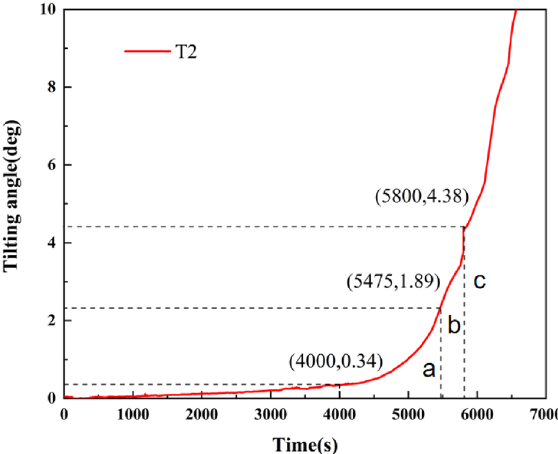
Figure 9. Curve of tertiary creep stage division, with ( a ) initial tertiary, ( b ) medium tertiary, and ( c ) high tertiary creep stages labeled on the